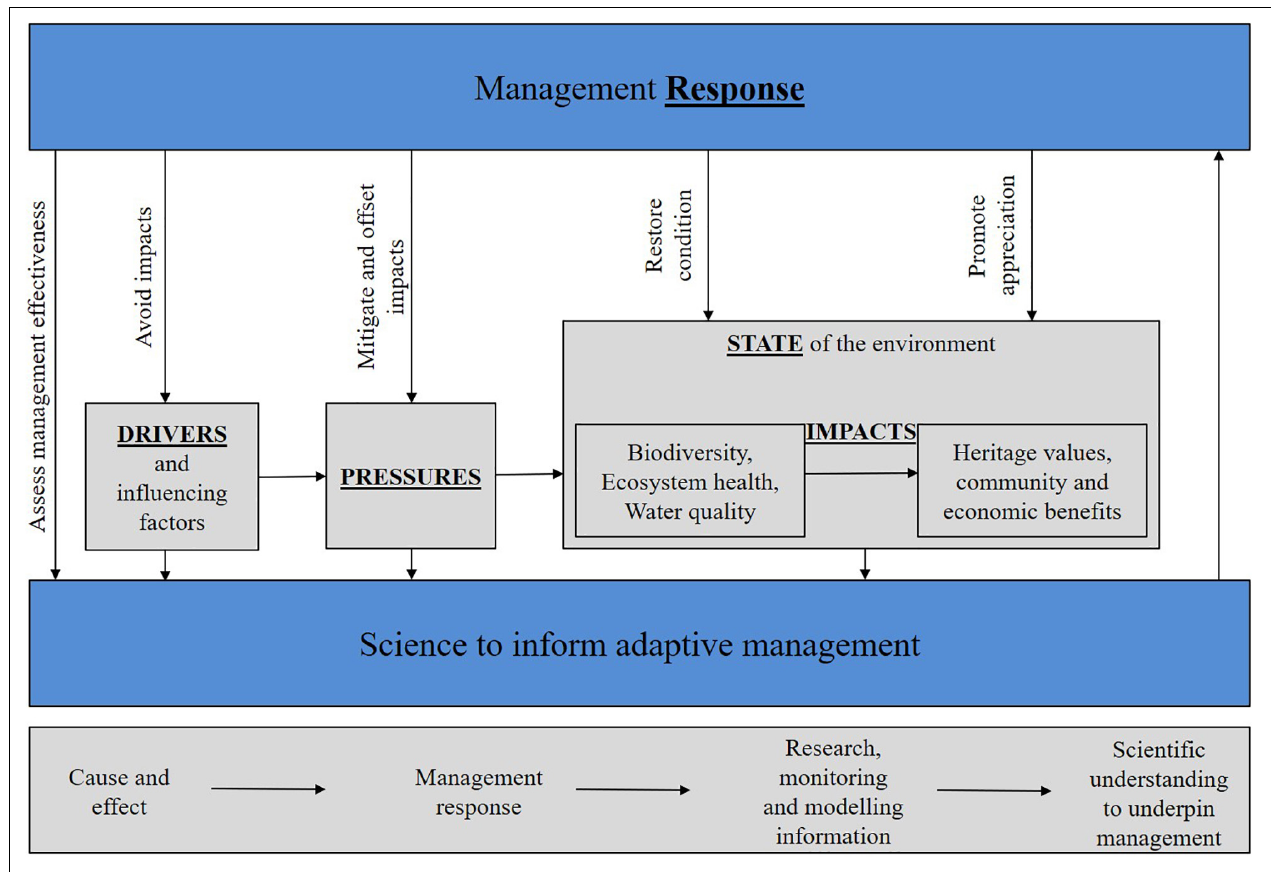
FIGURE 1 | Reef 2050 Plan adaptive management framework (Adapted from Commonwealth of Australia, 2018: 77).